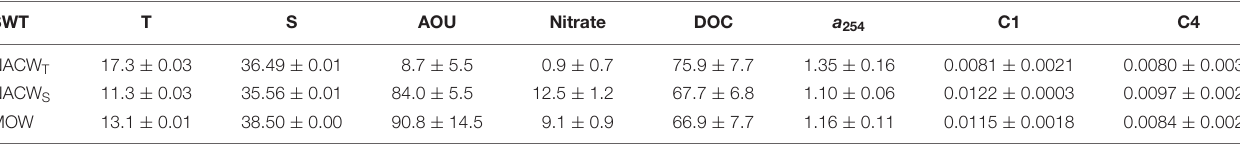
TABLE 3 | Biogeochemical and fluorescence typical values of selected water mass in OMP analyses in deep water. SWT T S AOU